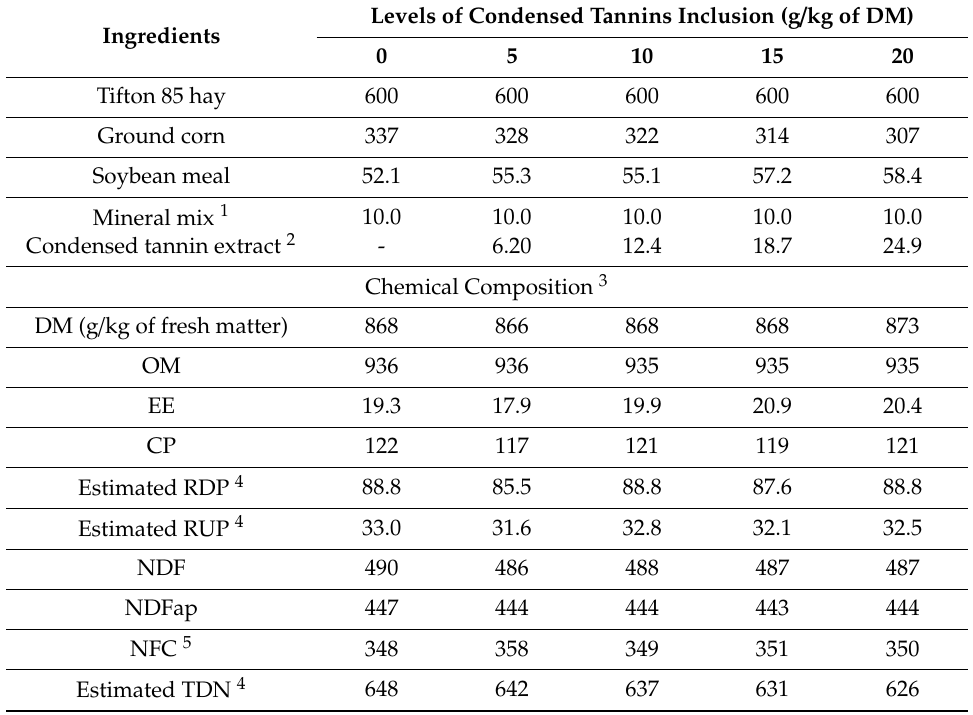
Table 2. Ingredients and chemical composition of experimental diets in g / kg